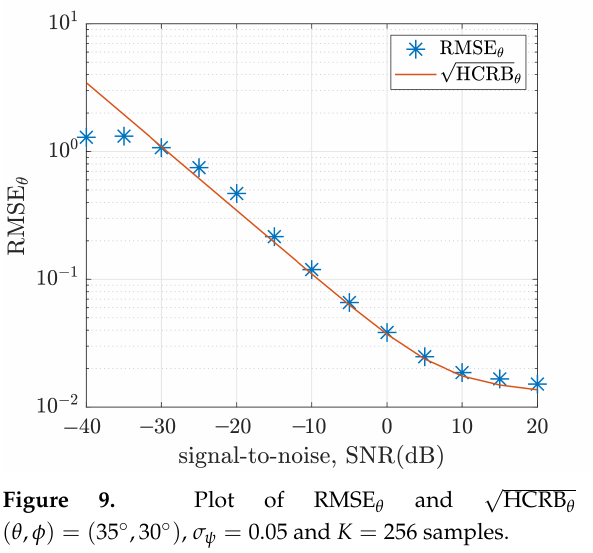
Figure 9. Plot of RMSE θ and ( θ , φ ) = ( 35 ◦ ,30 ◦ ) , σ ψ = 0.05 and K = 256 samples.